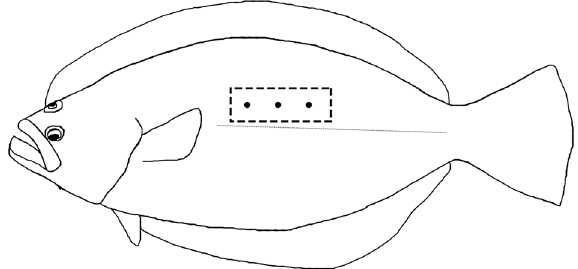
Figure 6. Sample sites in muscle for instrumental texture measurement. Three sampling points were detected in epaxial muscle (between dorsal and tail, above the lateral line) for each